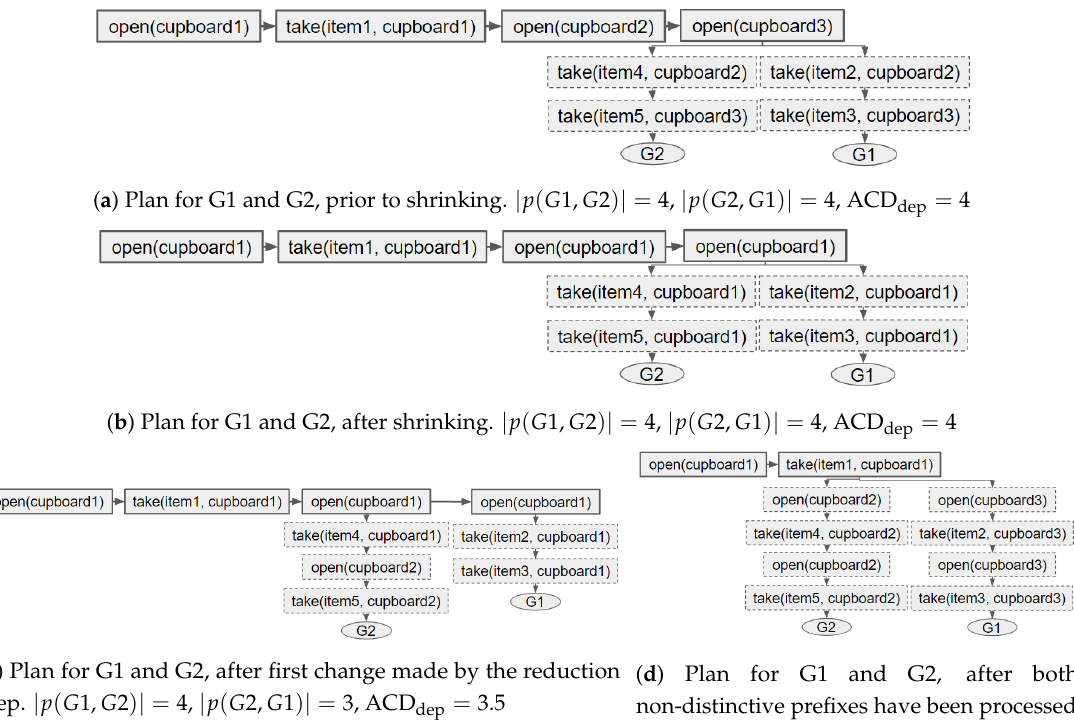
Figure 10. Example of shrinking the plans, then reducing the non-distinctive prefix. Only a single plan permutation is displayed. Rather than showing arrows to indicate when a non-distinctive action is counted multiple times to calculate | p ( G 1, G 2 ) | and | p ( G 2, G 1 ) | (as the dependency is required by multiple actions), these actions (dependencies) are